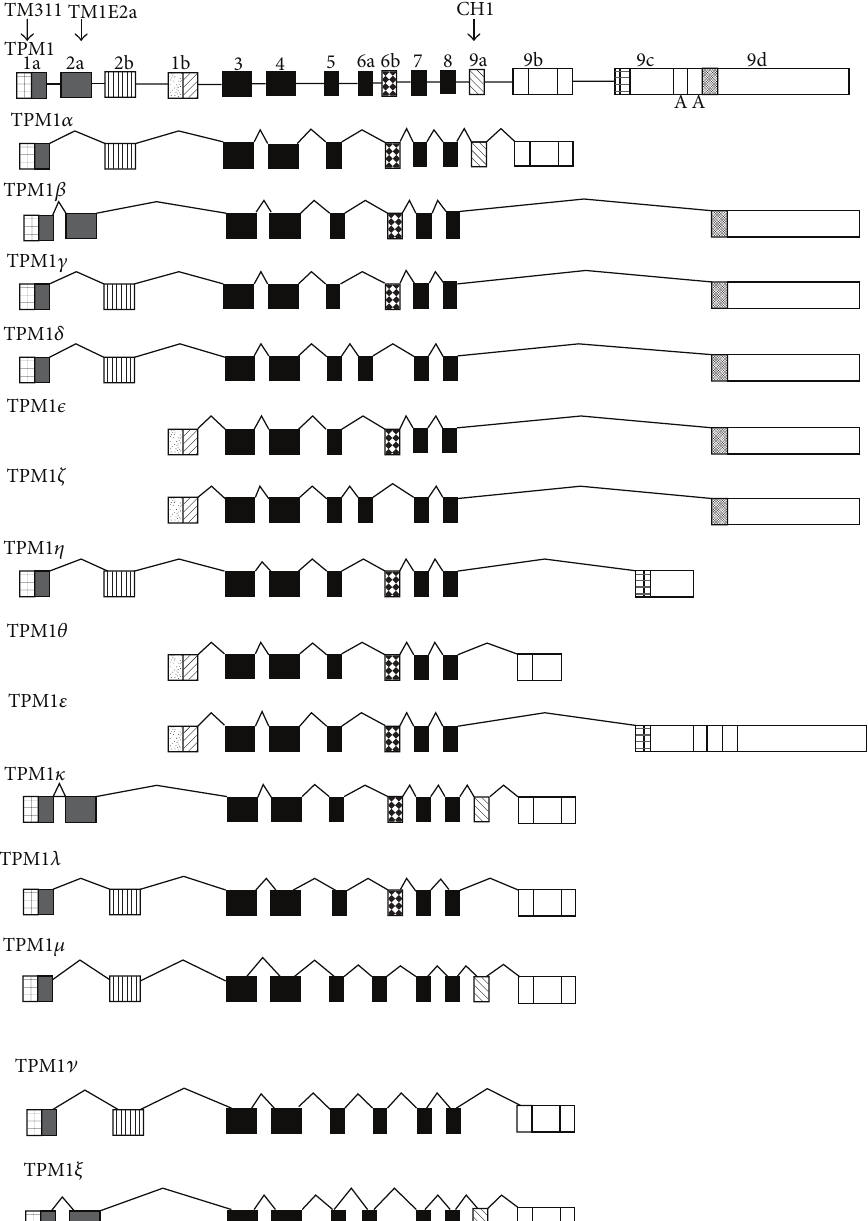
Figure 1: Cartoon showing the various exons (boxes) and introns (lines) of the human tropomyosin 1 gene and its various RNA isoforms identified to date. TPM1 𝜆 – 𝜉 are the newly described isoforms herein. The exons identified by the antibodies TM311, TM1E2 𝛼 , and CH1 are identified. Those exons that are translated as peptides are indicated by solid or hatched, and so forth, markings, while those that are not are left blank. The translation profiles for TPM1 𝜆 – 𝜉 are